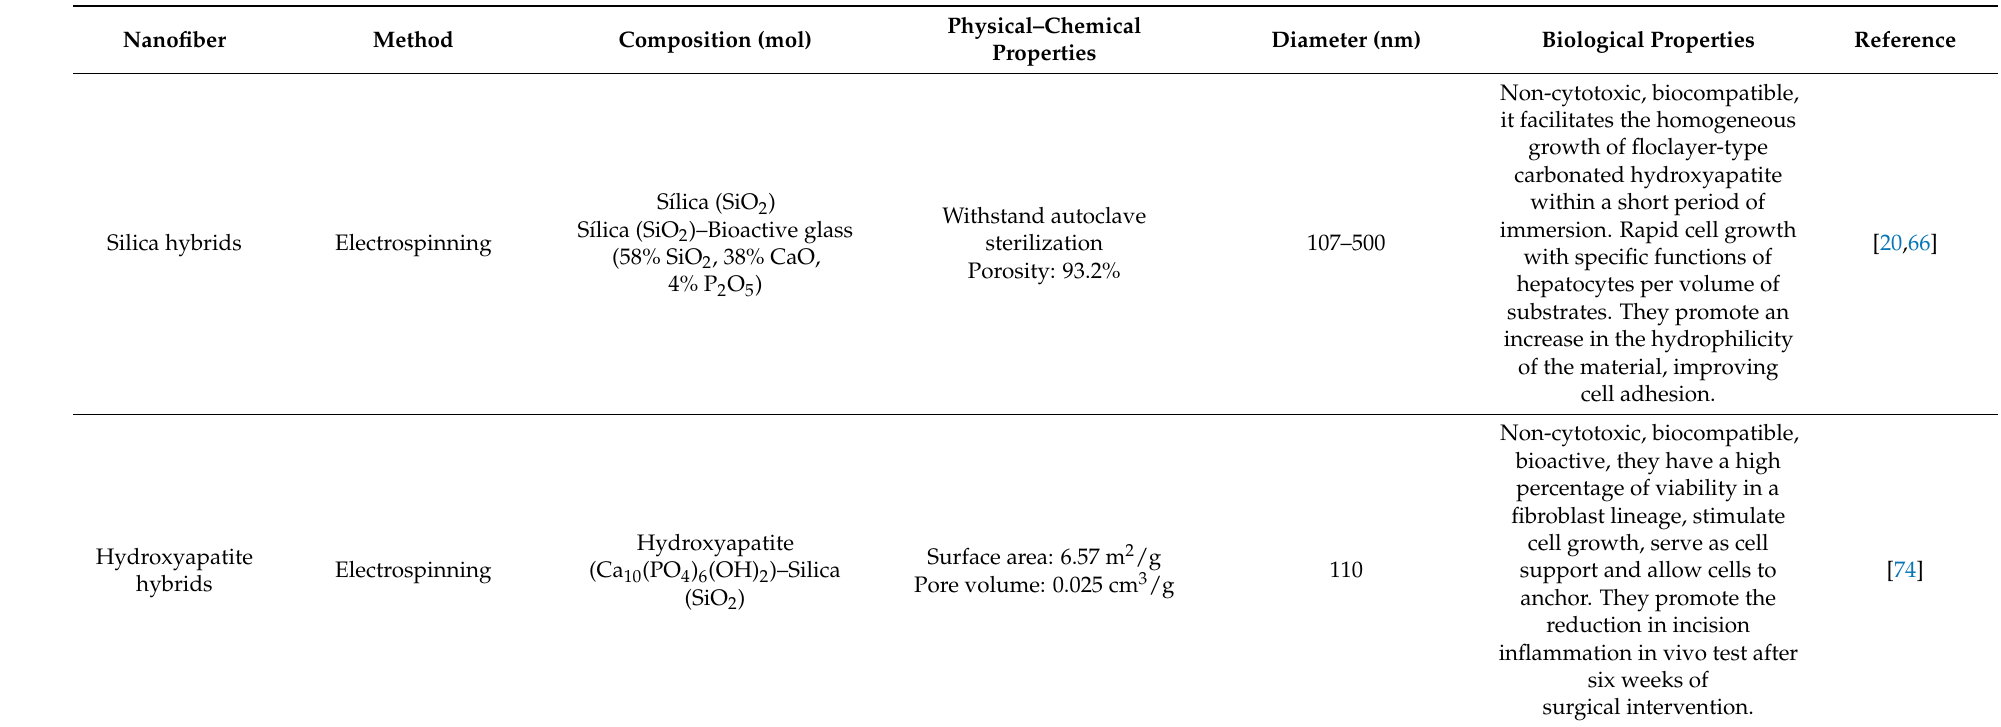
Table 1. Summary information about ceramic nanofibers for wound healing